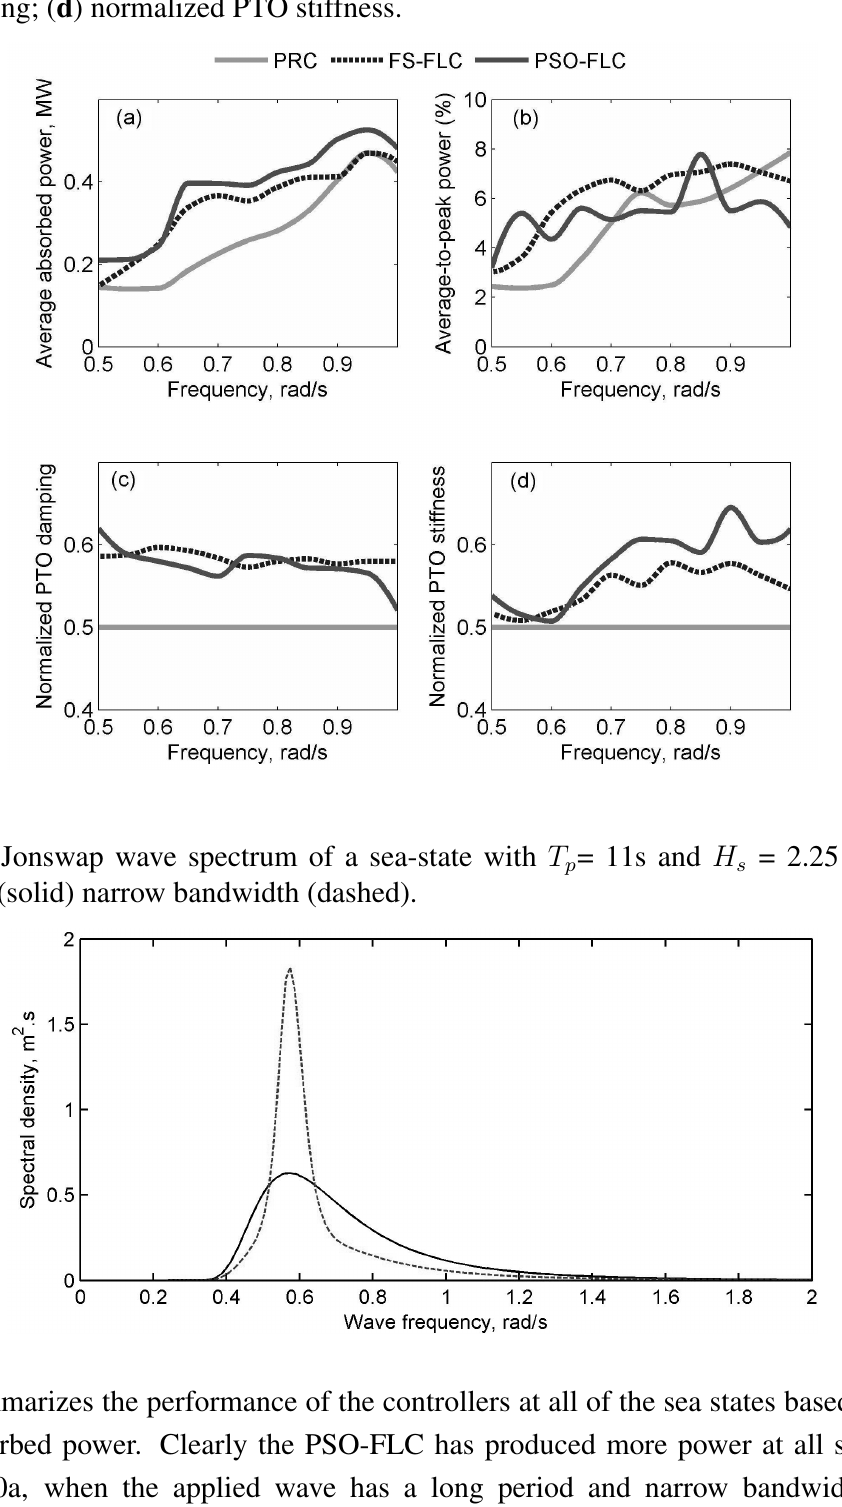
= 3 m and varying s